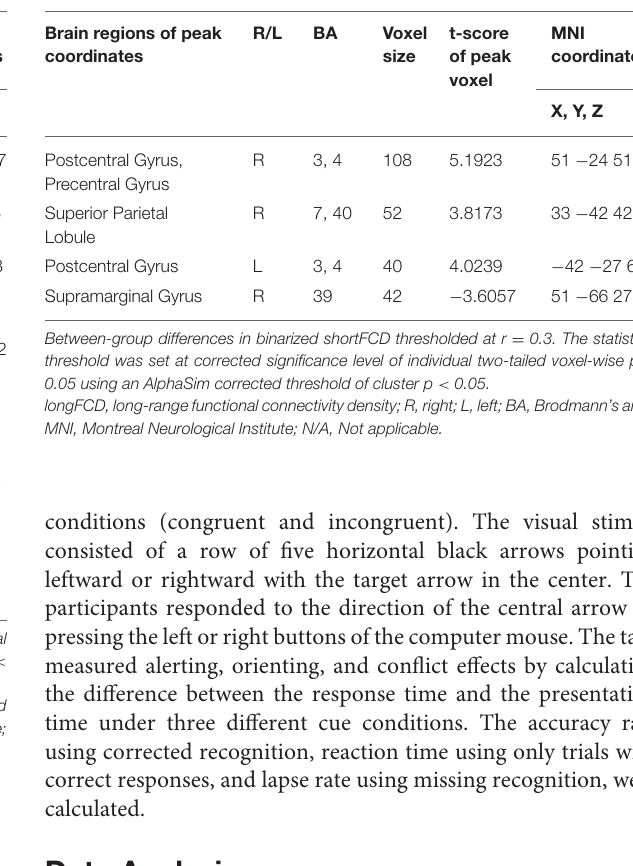
TABLE 2 | The binarized longFCD differences between SD and RW.